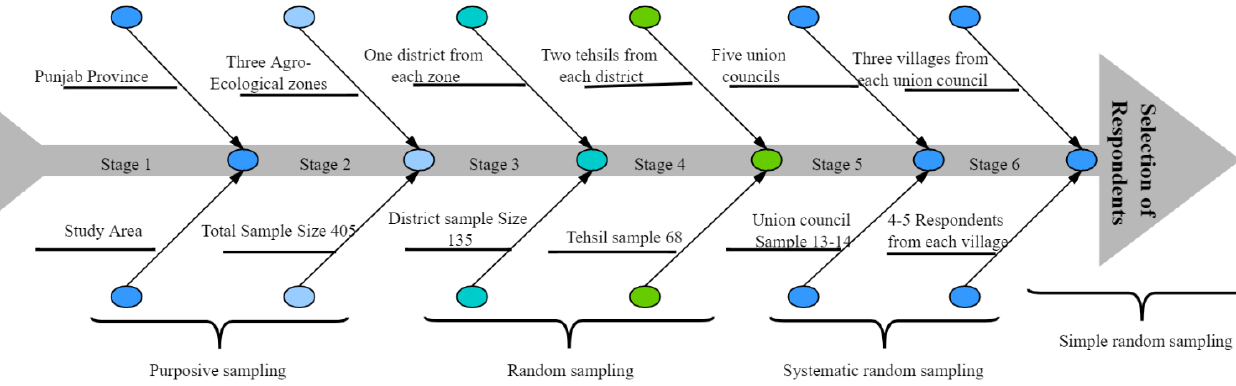
Figure 1. Map categorizing the agro-ecological zones of Punjab and the study area.